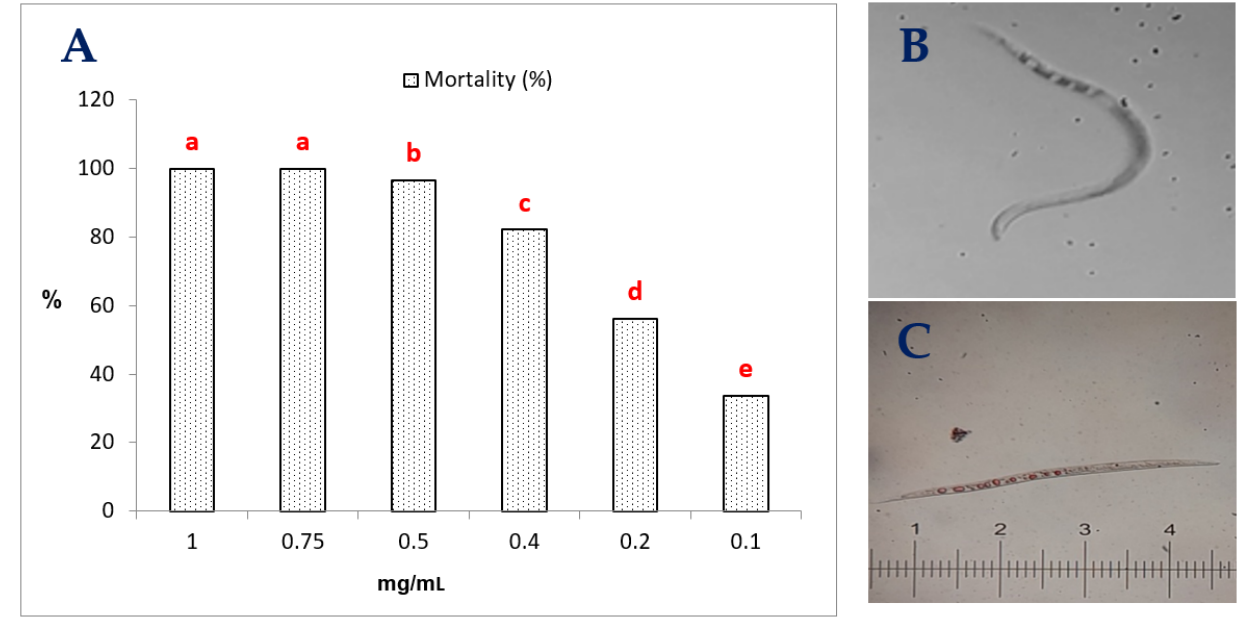
Figure 7. The anti- J2 nematodes activity of purified prodigiosin. The anti- J2 nematodes effect of prodigiosin ( A ). The experiments were conducted in triplicate and data were analyzed via the simple variance (ANOVA) then Duncan’s multiple range tests at p = 0.01 were performed. Values with the different letters are significantly different. The value of Least Significant Difference (LSD) and Coefficient of Variation (CV) were 0.872937 and 1.7646, respectively. The graph bio-activity was constructed by Microsoft Excel 2010. The mobilized J2 nematodes ( B ) became immobilized J2 nematodes ( C ) after 24 h of treatment with prodigiosin. The images of coffee nematode eggs and J2 nematodes were observed and recorded using an Optical Olympus Microscope (Model CH30RF200, Olympus Co., Tokyo, Japan).